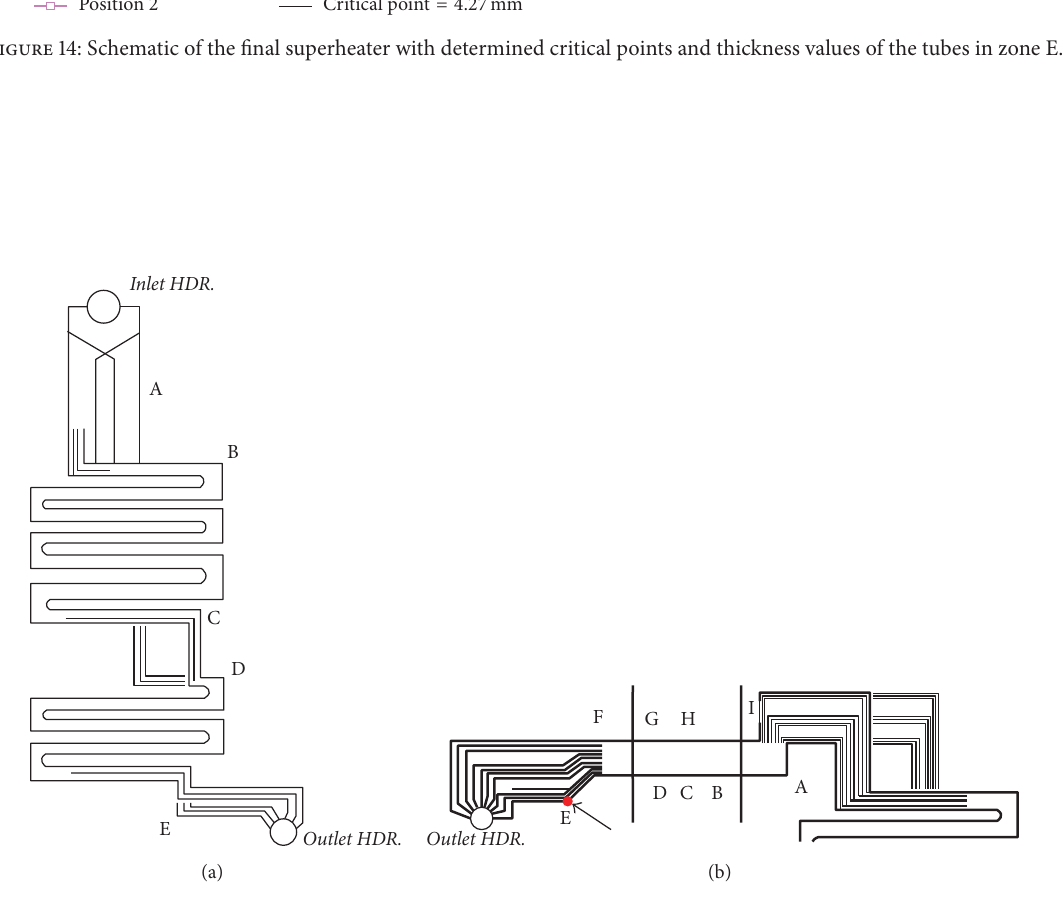
Figure 15: Schematic of (a) medium reheater and (b) final reheater with determined critical